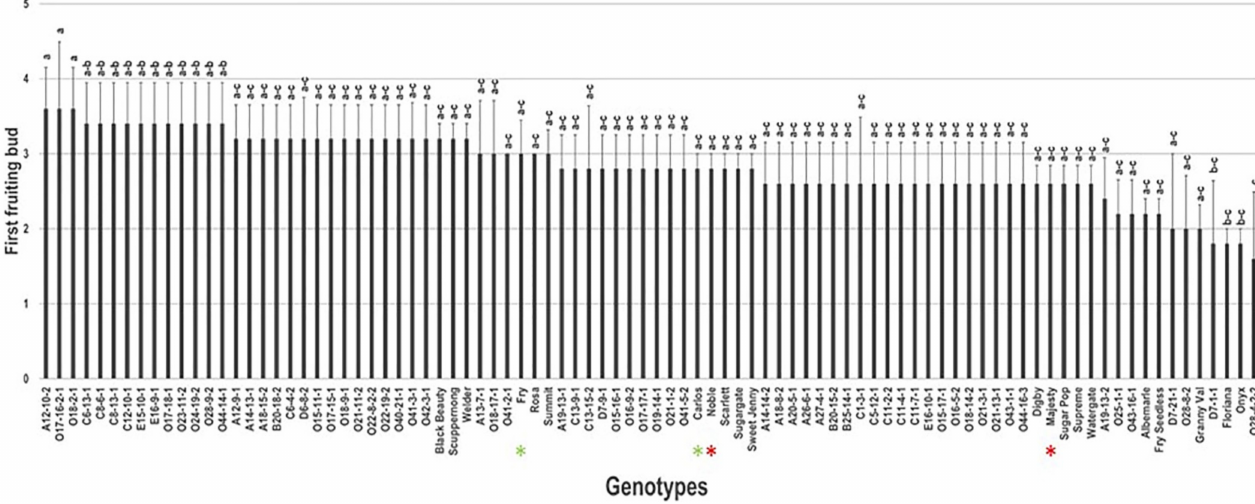
Figure 1. Characterization of first fruiting bud (FFB) trait among muscadine population ( n = 90). The bars represent the mean FFB position ( ± SD) results from three biological replicates (three vines) over three years ( n = 9). The y-axis refers to the position of the first fruiting bud. The x-axis refers to muscadine genotypes. Means within columns for the same letter followed by different letters differ significantly by Tukey’s test ( p < 0.05). The asterisk refers to standard commercial cultivars selected as reference genotypes in the current study, including Noble, Carlos, Majesty, and